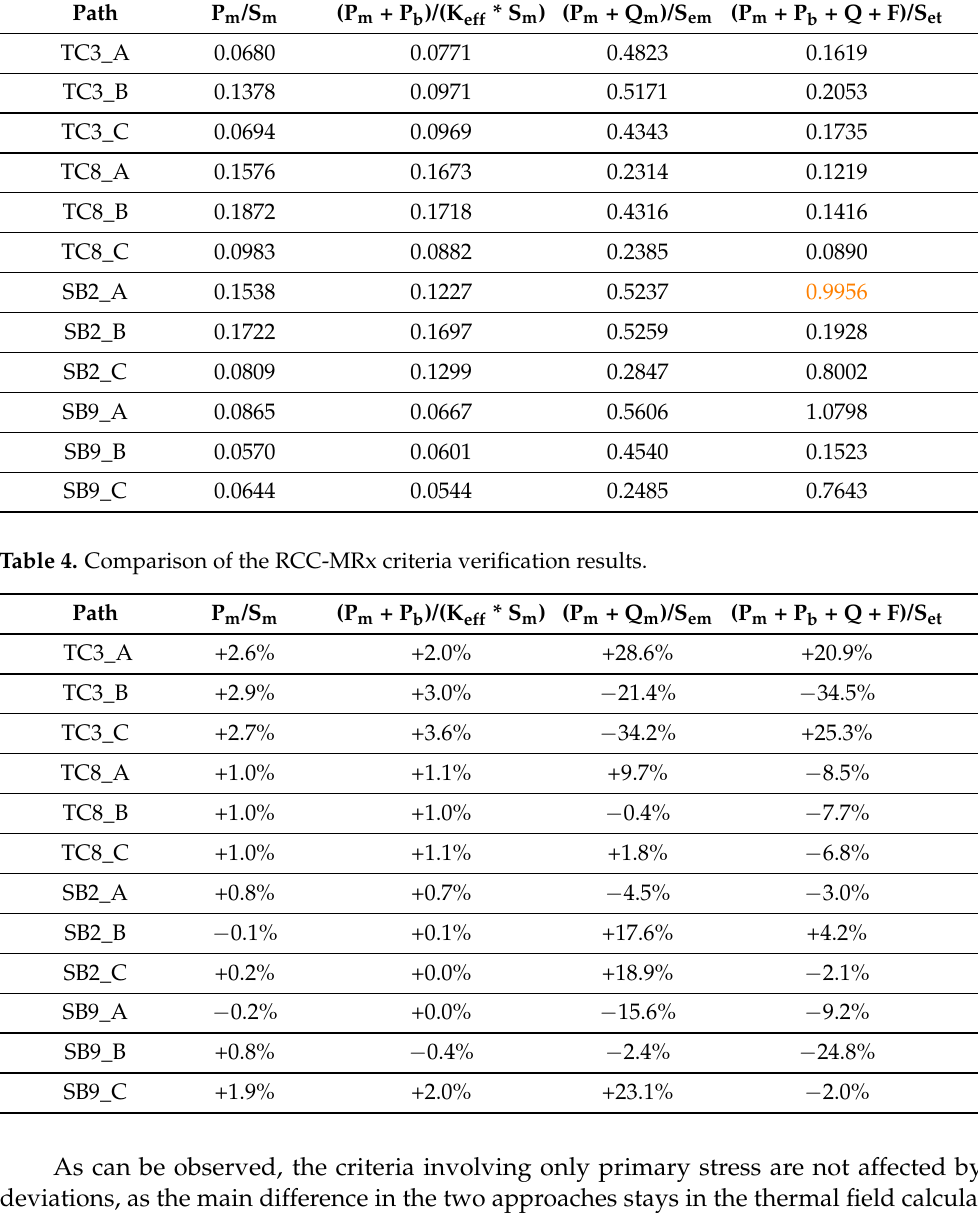
Table 3. RCC-MRx criteria verification in the pure FEM analysis.